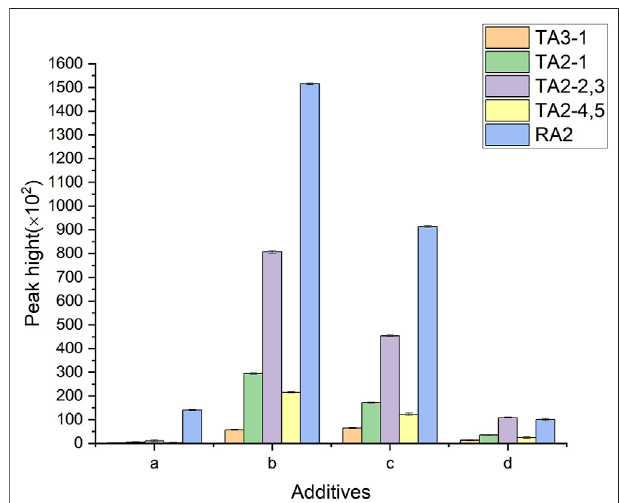
FIGURE 2 | Effect of different additives on the sensitivity of the analytes. (A – D) refer to the mobile phases without formic acid, the mobile phases with 0.1% formic acid, the mobile phases with 0.2% formic acid, and the mobile phases with 10 mM ammonium